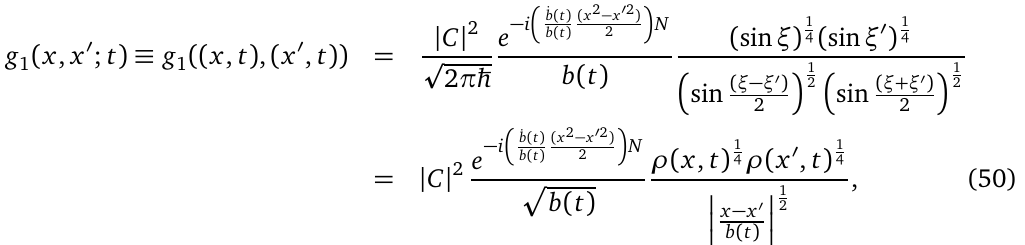
Figure 5: Absolute value of the one-particle density matrix at equal times, | g (left) and at different times, | g parameters are chosen as follows: ω